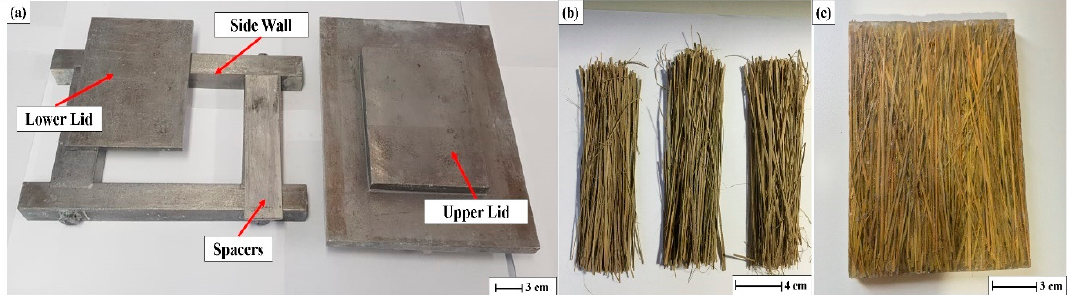
Figure 3. Methodology for processing the composite plates: ( a ) Metallic mold, ( b ) cleaned and dried carnauba fibers, and ( c ) cured composite plate.